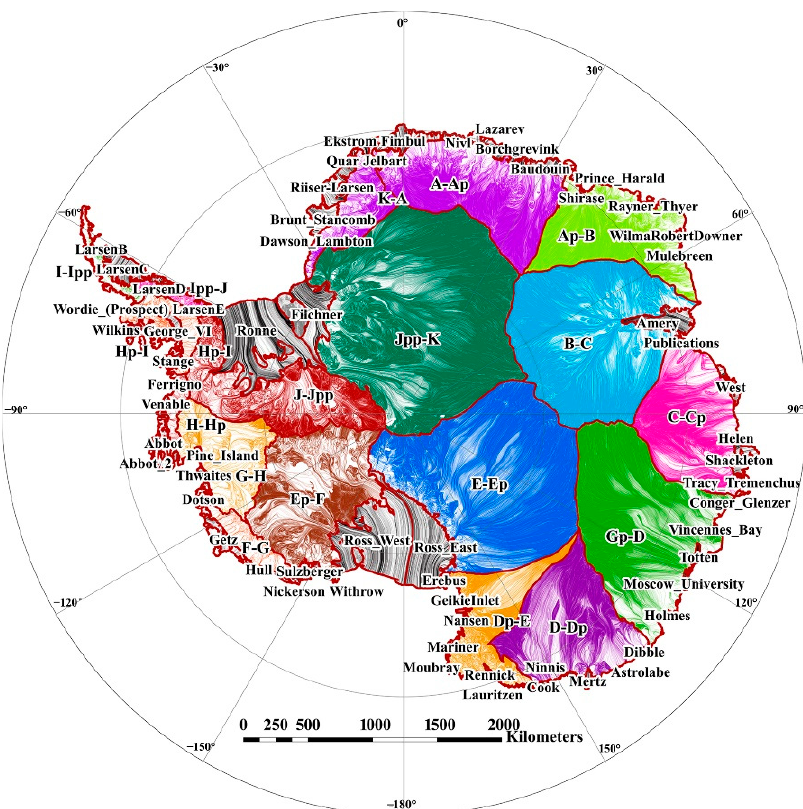
Figure 12. Parts of detailed comparisons at the boundary of the basins between IMBIE basin systems and re-divided Antarctica basin systems. The ice flow lines belonging to different basins are ren- dered in different colors, where the first row ( a – c ) is the IMBIE basin systems and the second row ( a1 – c1 ) is the corresponding re-divided Antarctica basin systems.